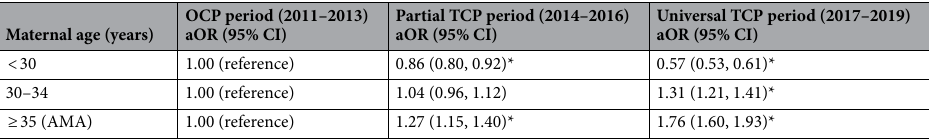
Table 2. Association between maternal age and policy changes. OCP (One-child policy), TCP (Two-child policy), AMA (advanced maternal age), Adjusted for maternal education, occupation, and parity; * = P < 0.05.